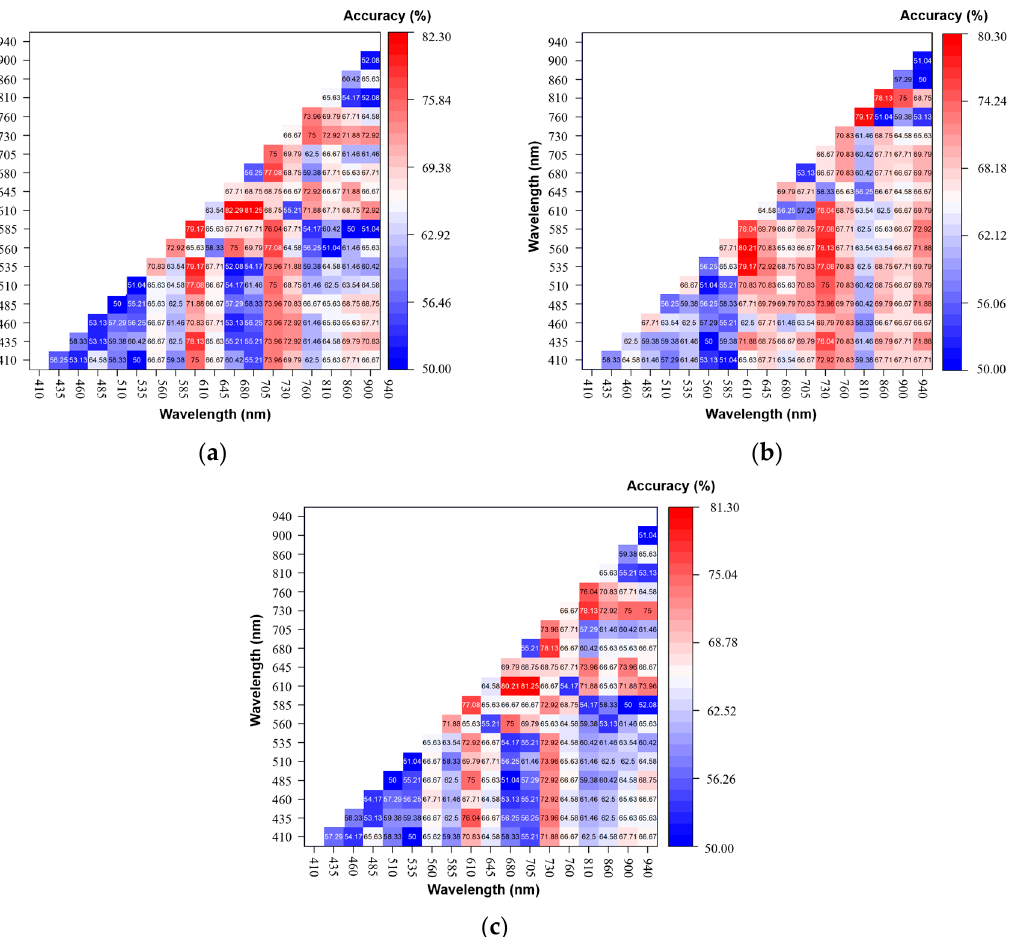
Figure 6. The discriminative effect of a single variable of spectral shape feature on pork freshness: ( a ) SR; ( b ) SD; ( c ) NSID. ( a ) SR; ( b ) SD; ( c )